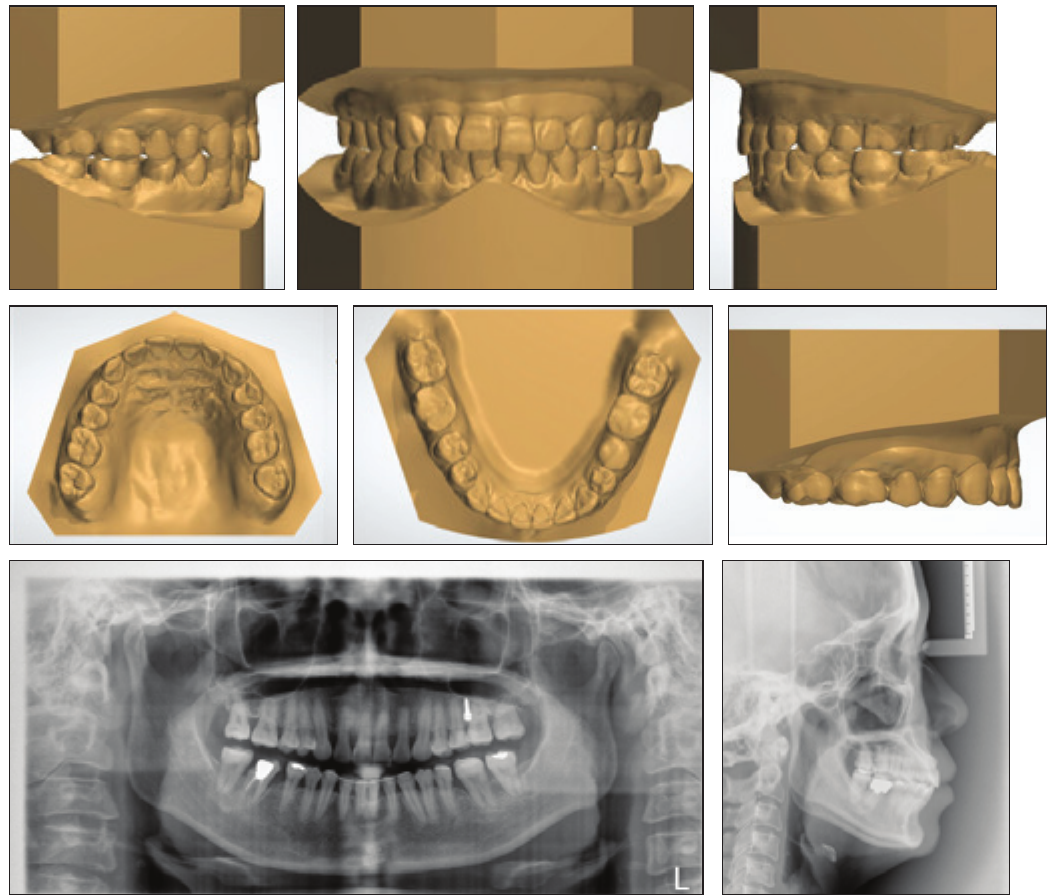
Figure 5. Post-treatment dental cast, lateral cephalometric and panoramic radiographs.